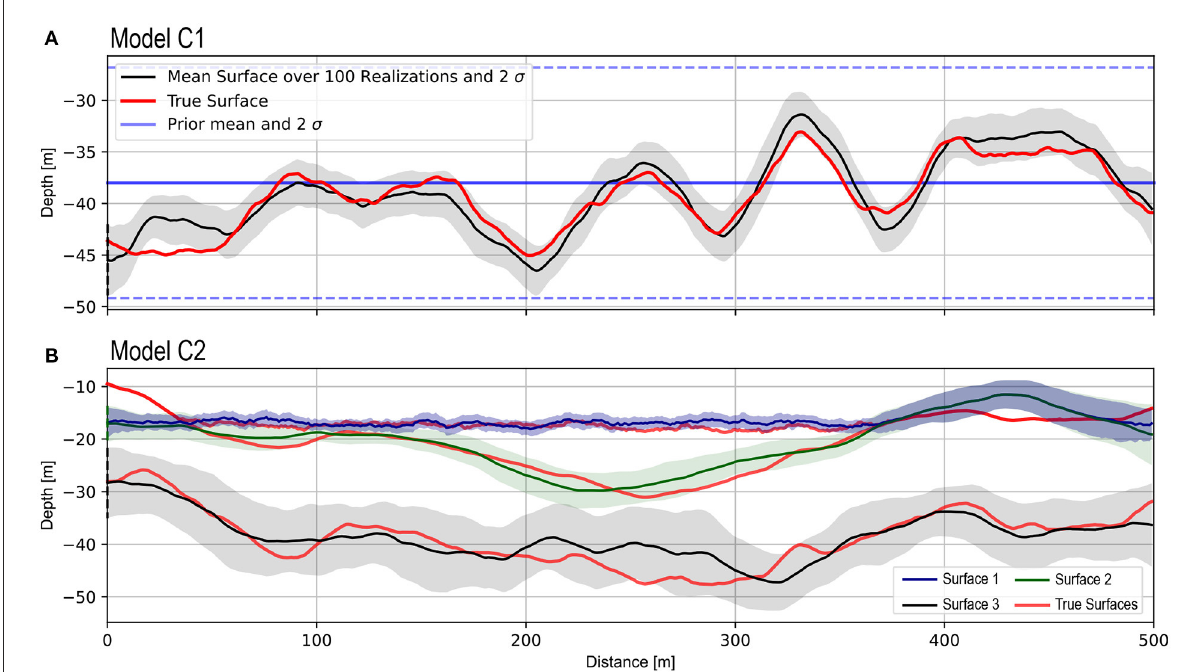
FIGURE6 Low-fidelity inversion results for models C1 (A) and C2 (B) over 100 members and two iterations each. The model C1 has only one surface, and the model C2 has three surfaces. The shading areas correspond to 2 σ